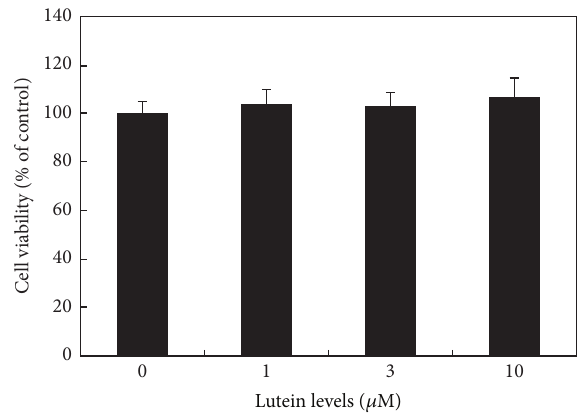
Figure 1: Effects of lutein on cell viability of cultured human CE cells. Cells were cultured with different levels of lutein and cell viability was measured by MTT assay. Lutein at 1, 3, and 10 𝜇 M did not affect the cell